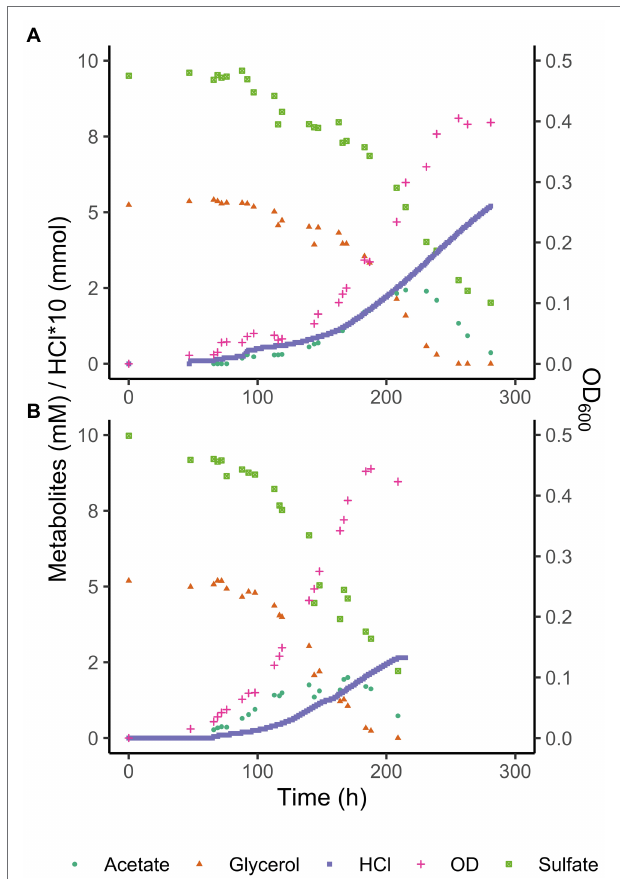
FIGURE 3 | Glycerol, total acetate (undissociated + dissociated) and sulfate concentrations, and OD 600 of Acididesulfobacillus acetoxydans strain INE grown in bioreactors at pH 3.9 (A) and pH 5 (B) . Concentration profiles of glycerol, sulfate, acetic acid, as well as OD 600 and HCl addition are shown for one reactor at each pH value for